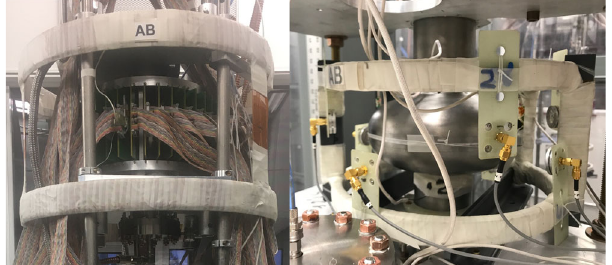
FIG. 6. Single cell cavity setup for evaluating sporadic quench- ing with a temperature map (left) and second sound sensors (right).